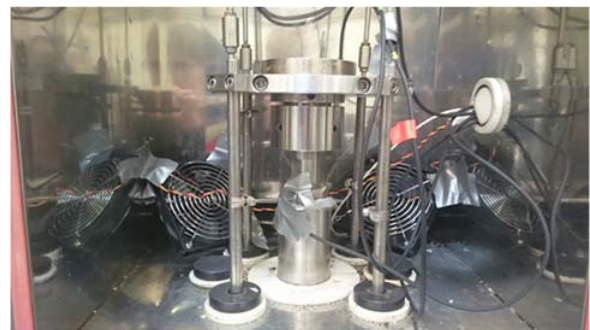
Figure 7. Improvised, improved setup to increase air flow velocity in the 2003 device.